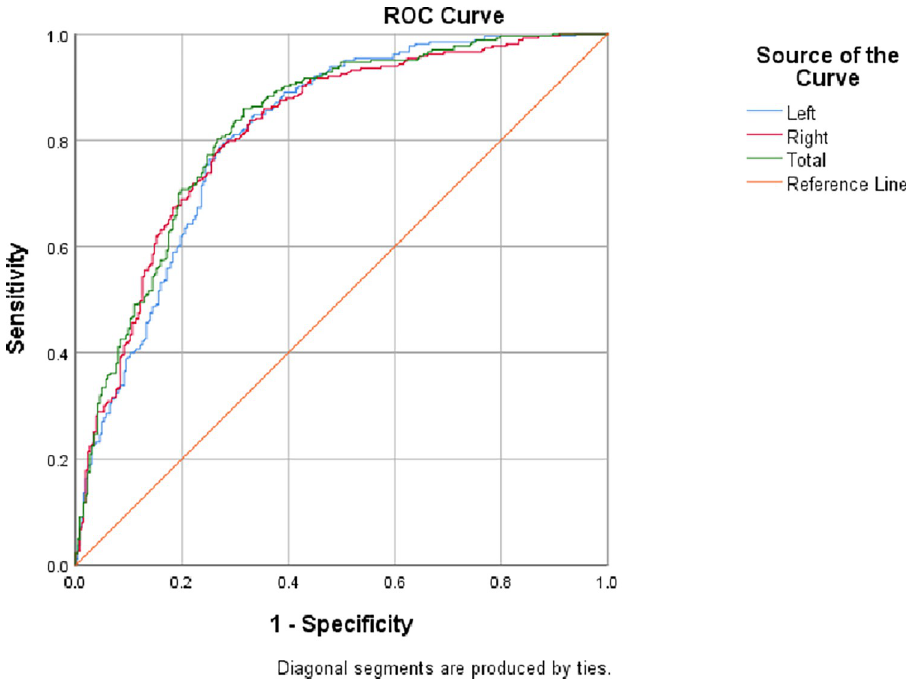
Fig 2. The ROC curves and their areas under the ROC curves of the left, right and total hippocampal volumes for the detection of Alzheimer’s disease.